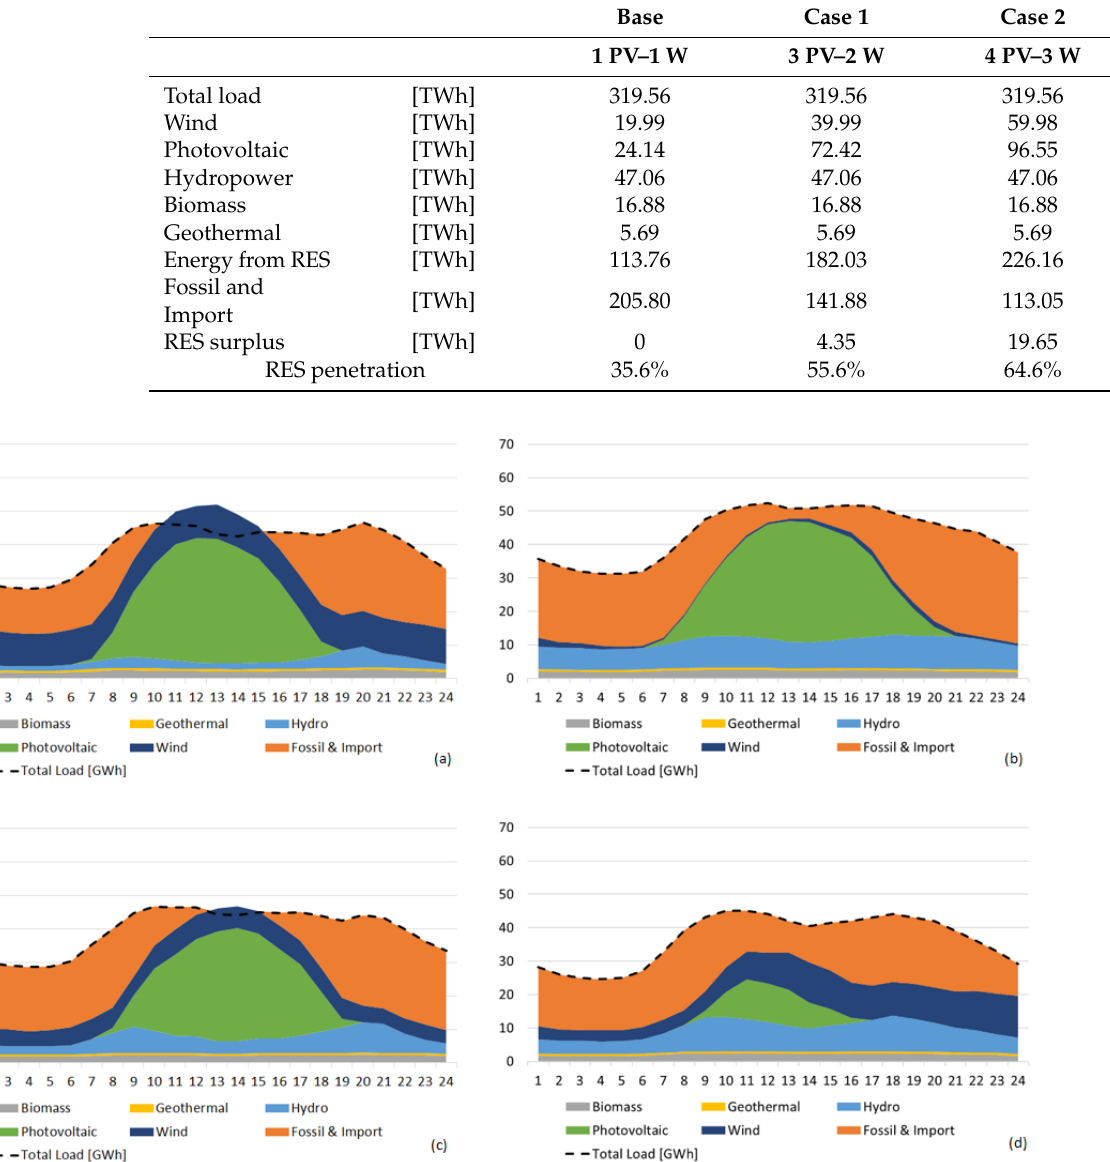
Table 1. Summary of the considered energy production.